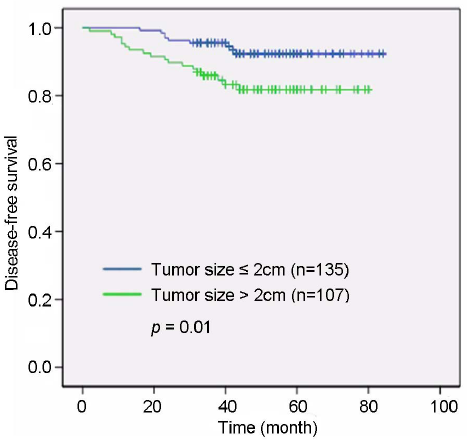
Figure 2. Univariate analysis showed a significant association between tumor size and disease-free survival. Tumor sizes . 2 cm were correlated with a shorter disease-free survival duration than found in patients with tumor sizes # 2 cm (P=0.01).